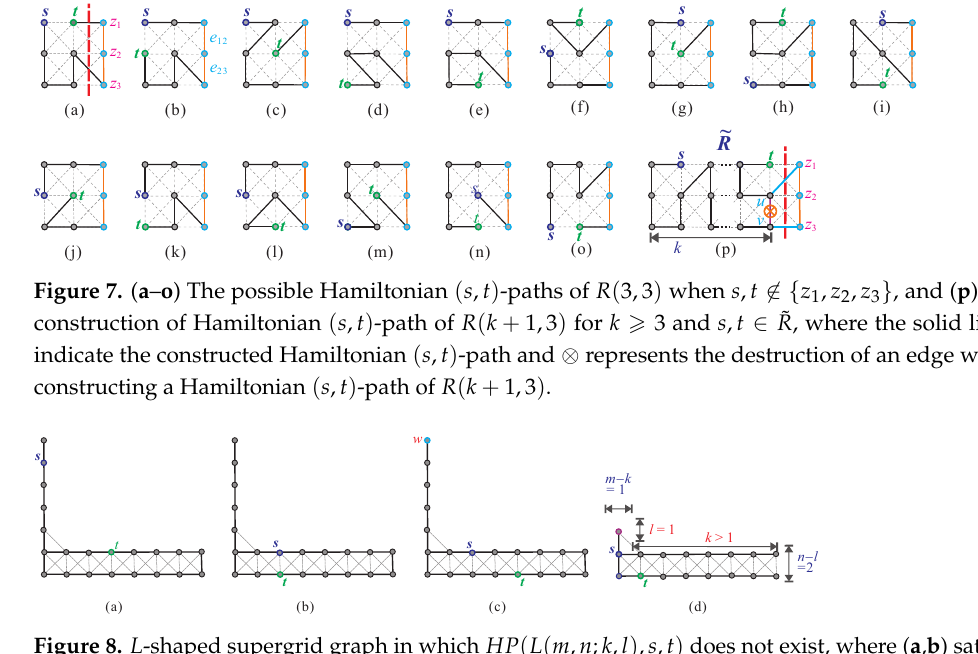
Figure 8. L -shaped supergrid graph in which HP ( L ( m , n ; k , l ) , s , t ) does not exist, where ( a , b ) satisfy condition (F1), ( c ) depicts condition (F2), and ( d ) shows condition